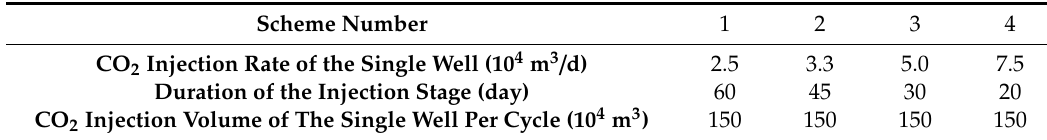
Table 6. CO 2 injection rate in different schemes.